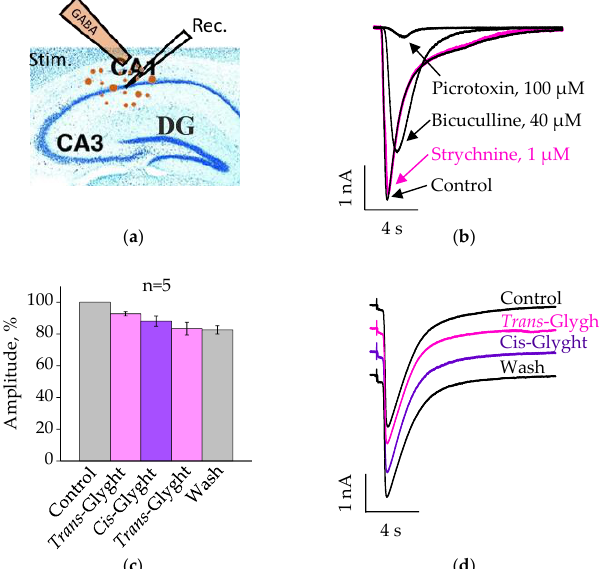
Figure 3. Glyght (100 µM) did not affect the currents induced by extracellular application of GABA on the hippocampal CA1 pyramidal neurons: ( a ) the position of the application pipette filled with 300 µM GABA and the recording electrode (Rec.) on a slice; ( b ) superimposed traces of average ( n = 4–8) GABA-induced currents recorded in control ACSF, and after addition of 1 µM of strychnine, 40 µM of bicuculline and 100 µM picrotoxin (mouse P8). Note complete inhibition of the GABA- induced currents by picrotoxin; ( c ) average normalized amplitudes of GABA-induced currents after application of Glyght in trans -, cis -configurations and after washing as a percentage of the controls. Mean percent ± SEM, n = 5, P7–8; ( d ) superimposed examples of traces of average ( n = 5–7) GABA- induced currents recorded in control ACSF, after application of Glyght in trans -, cis -configurations and washing. Recordings were obtained from P7 mouse.